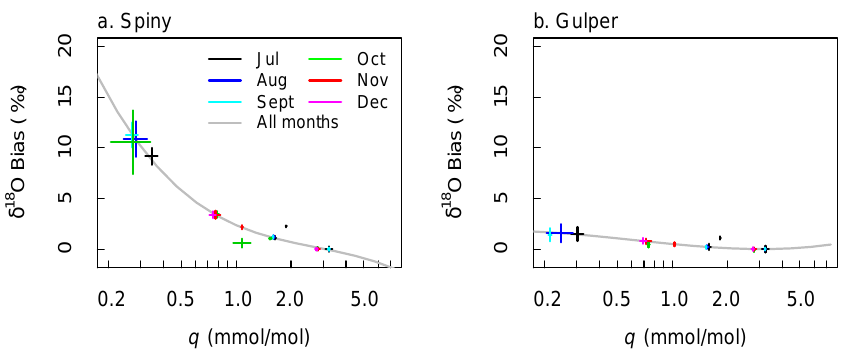
Figure 5. Monthly mean concentration-dependent biases in δ 18 O (‰) for the Summit instruments shown as crosses whose width and height represent 1 σ (standard deviations) in δ 18 O and q . The concentration-dependence characterizations obtained when fitting a locally weighted polynomial regression to all 6 months of data are represented by gray